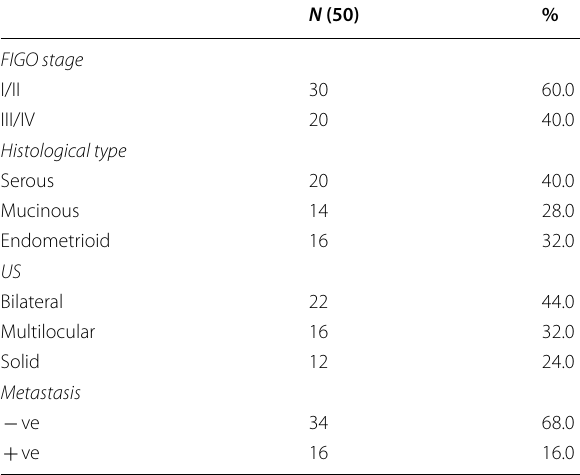
Table 2 Clinical characteristics of cancer patients